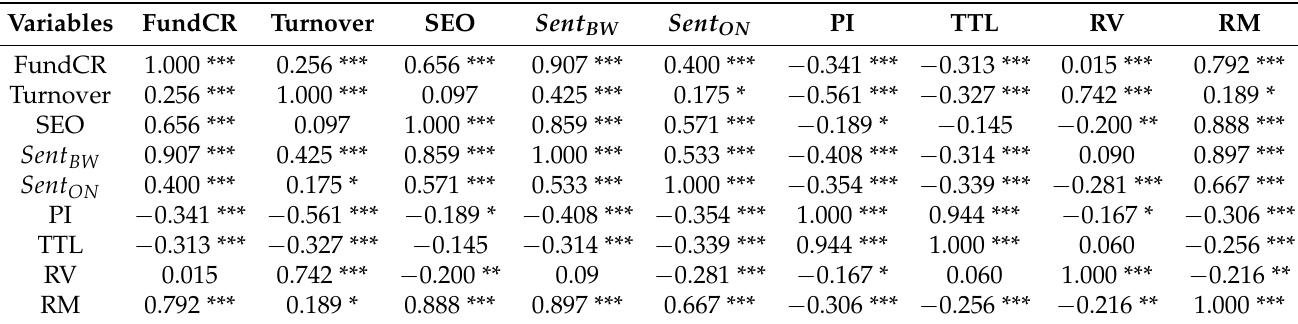
Table 3. Correlation analysis of variables of